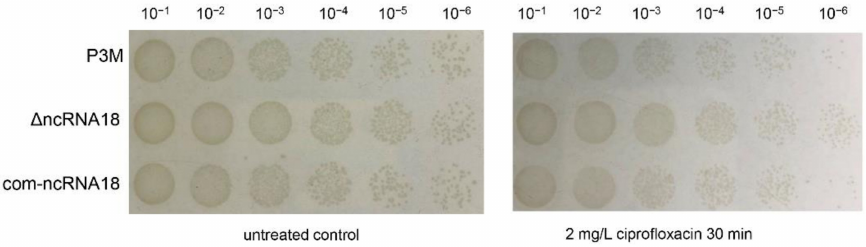
Figure 2. Spot growth assays of wild-type P3M, ncRNA18 deletion mutant ( ∆ ncRNA18), and ncRNA18 complemented strain (com-ncRNA18), with or without ciprofloxacin treatment. Survival data were obtained from three independent repeated tests ( n =